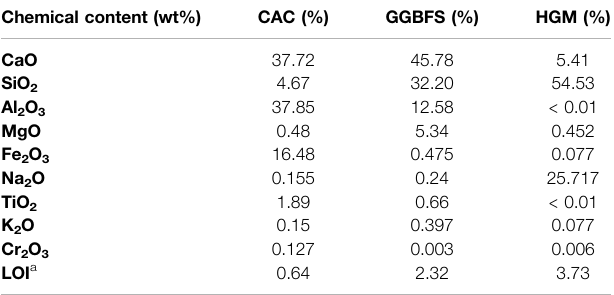
TABLE 3 | XRF results and loss of ignition (LOI) of